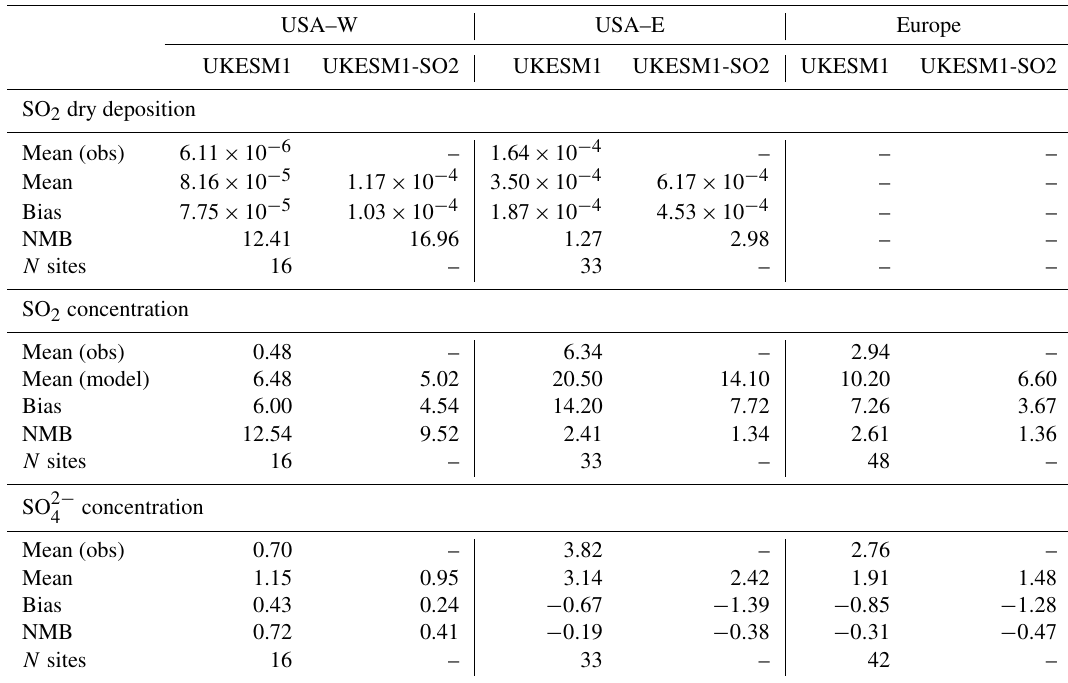
Table 7. Statistics for mean annual surface SO 2 and SO 2 The mean seasonal values are averaged over the period 1987–2014. The units for SO 2 and SO 2 − for SO 2 dry deposition flux are kgm − 2 yr − 1 for SO 2